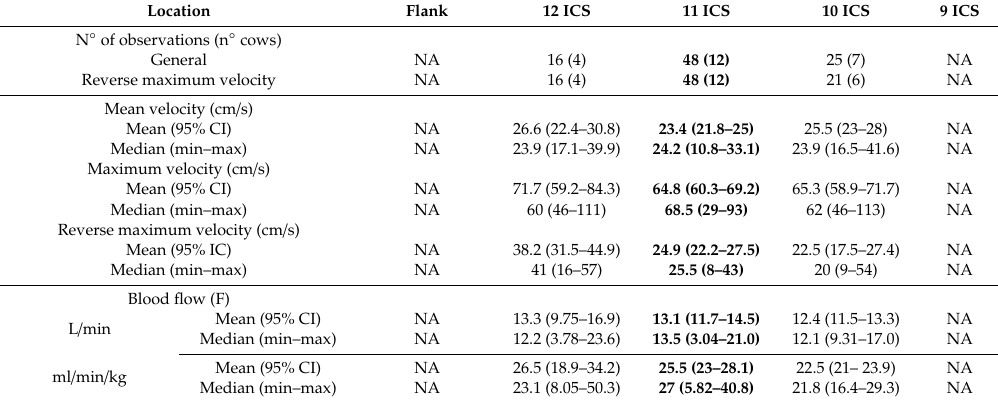
Table 3. Results of ultrasonography examination of the portal vein expressed as mean (95% CI) and median (minimum–maximum). Values obtained in the most frequent location are highlighted in bold. Location Flank 12 ICS 11 ICS 10 ICS